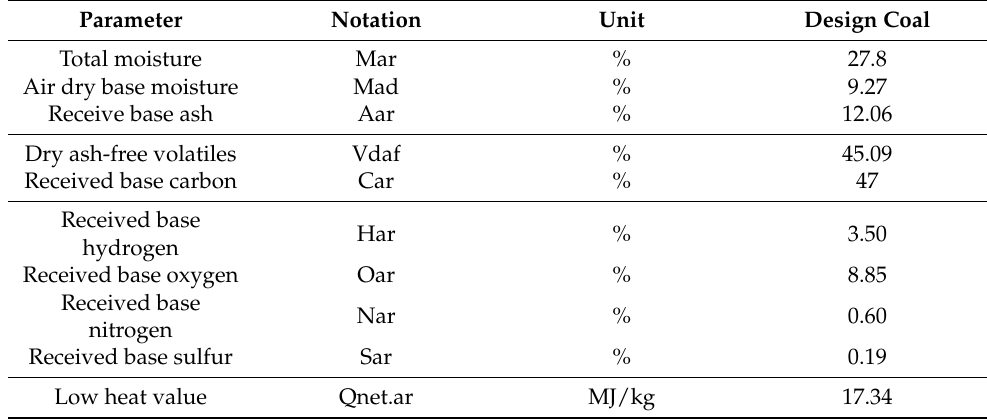
Table 2. Design coal